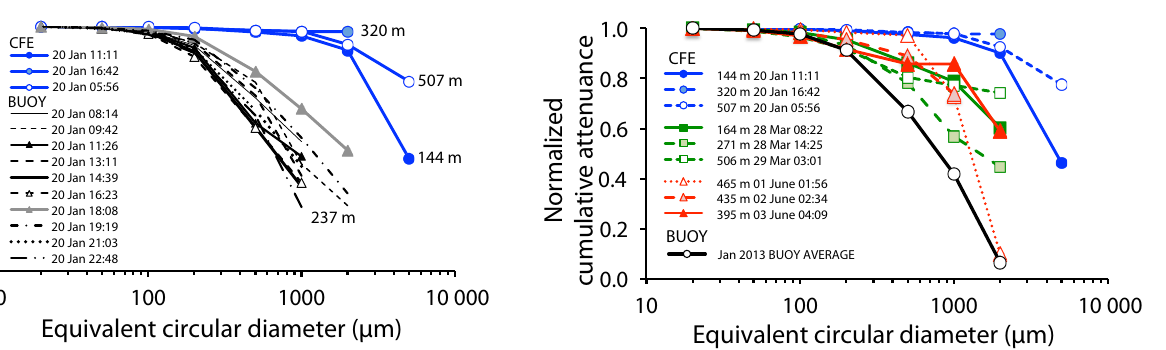
Figure 11. Comparison of normalized cumulative volume atten- uance particle size distributions (NCVA-PSD) from CFE deploy- ments in May 2012 (red lines and symbols), January 2013 (blue), and March 2013 (green). Shown in black is the average NCVA-PSD from BUOY-OSR deployments. No CFE data from any of the three expeditions overlapped BUOY-OSR results from January 2013;